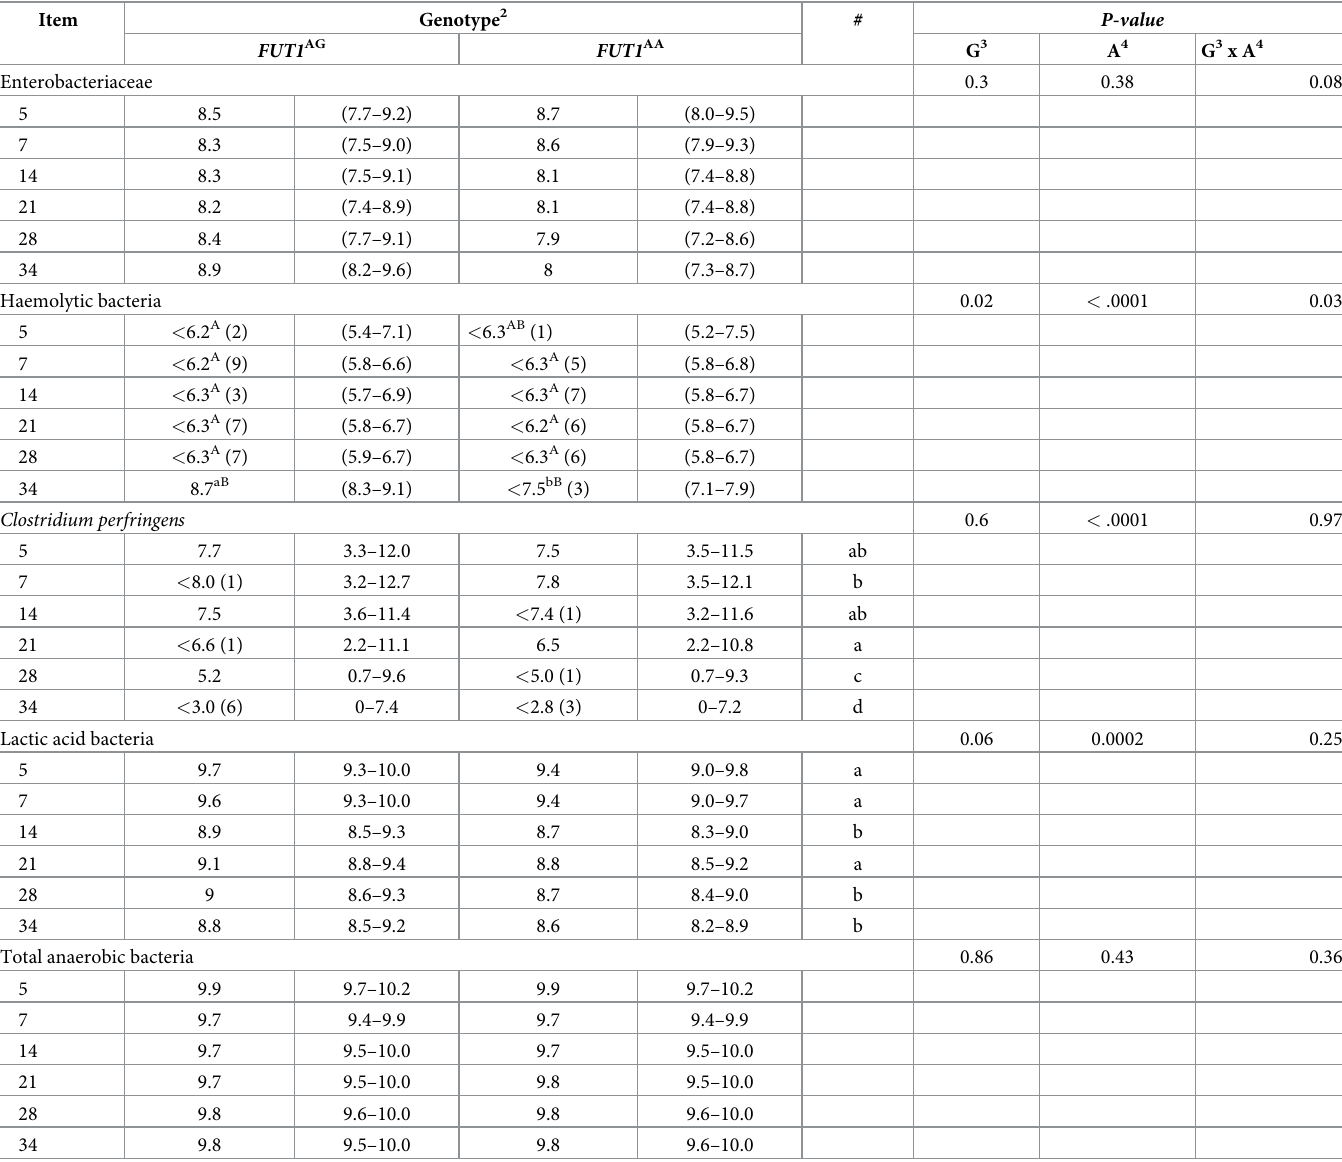
Table 2. Enumeration (log cfu/g sample) of selected microbial groups in faeces from piglets at 5, 7, 14, 21, 28 and 34 days of age 1